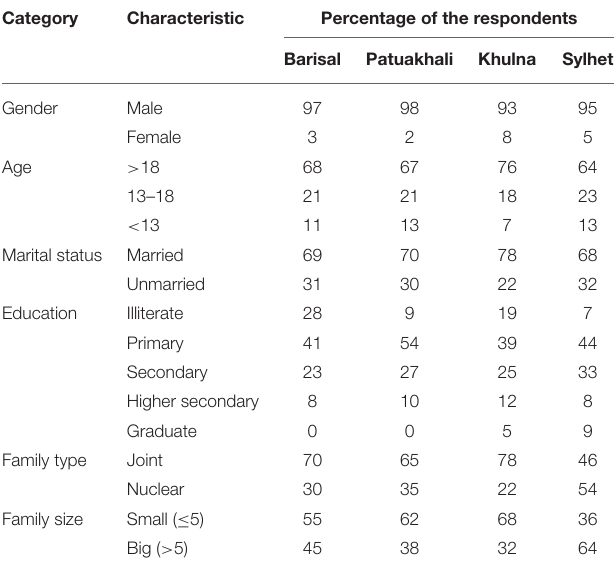
TABLE 1 | Demographic status of fish-farming households of the four studied districts.